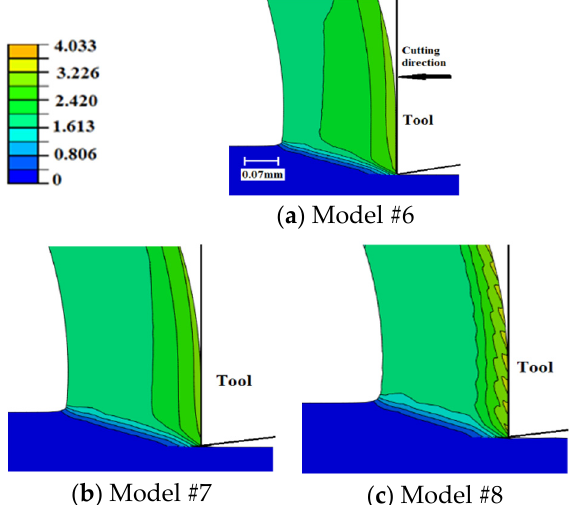
Figure 12. Equivalent plastic strains in the chip generation zone—sharp tool [23].